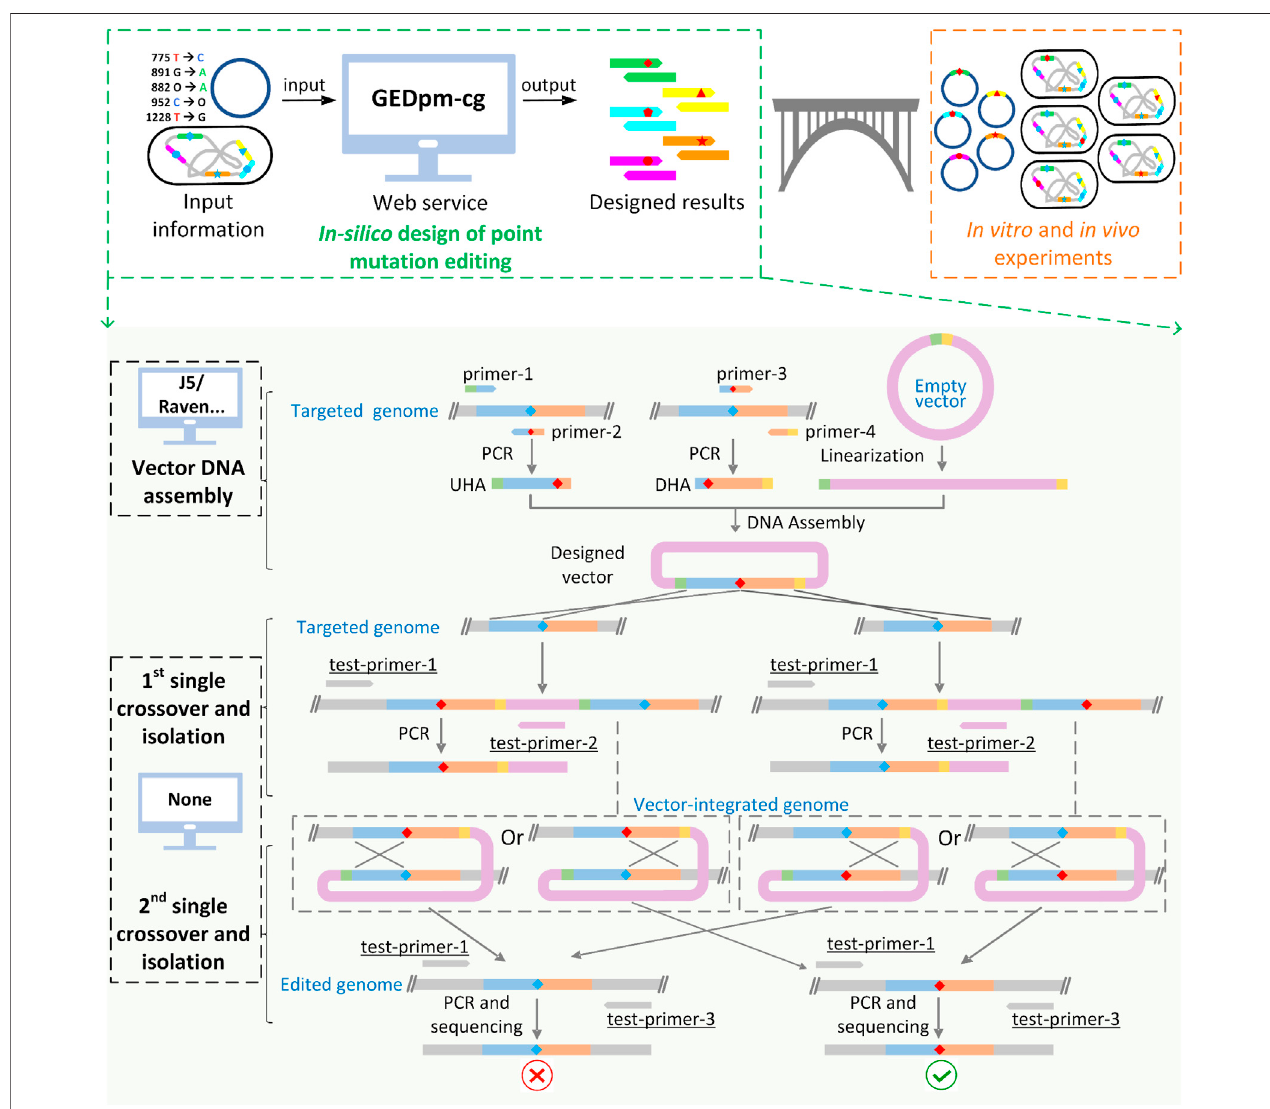
FIGURE 1 | Schematic diagram of GEDpm-cg and the point mutation editing technique based on uploaded sequences. GEDpm-cg is a web-based computer- aided design tool for the construction of genomic point mutations in C. glutamicum . When input fi les containing information of point mutations, vector and targeted genome are uploaded, GEDpm-cg is able to provide precise and high-throughput in-silico designed results for in vitro editing vector DNA assembly and in vivo point mutation editing in C. glutamicum . The design of point mutations by GEDpm-cg can be divided into the overlap-based vector DNA assembly and the suicide plasmid-mediated counter-selection point mutation genome editing. For vector DNA assembly, design tools such as j5 or Raven are able to assist the design of vector DNA assembly for biologists, while no tool is available for the design of suicide plasmid-mediated counter-selection point mutation genome editing. UHA, upstream homologous arm; DHA, downstream homologous arm; green band, homologous end between UHA and vector; yellow band, homologous end between DHA and vector, blue diamond, base before point mutation; red diamond, base after point mutation. Underlined names indicate the easily-neglected veri fi cation primers.